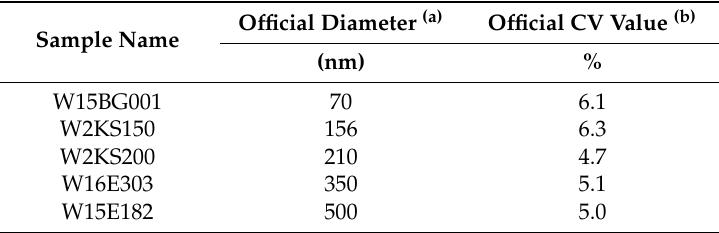
Table 1. Characteristics of polystyrene latex particles used in this study.